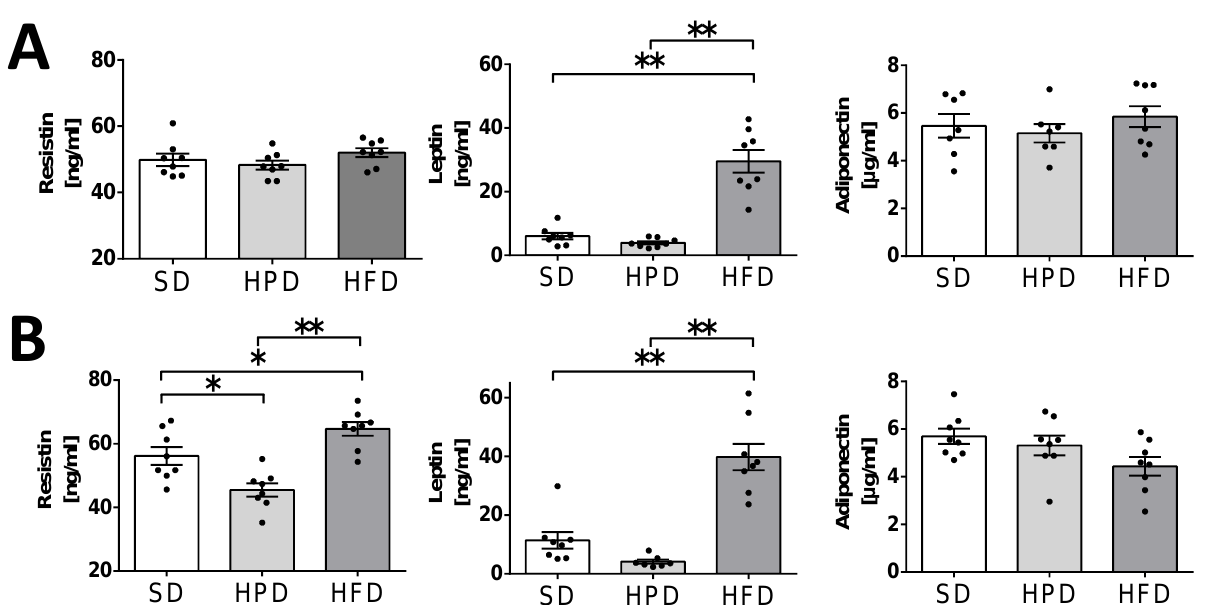
Figure 3. The effects of the standard (SD), HFD, and HPD on resistin, adiponectin, and leptin concentrations in blood serum after 60 ( A ) and 120 ( B ) days. Values presented are means and SEM for n = 8; significant differences between means for control and experimental groups are marked for p < 0.05 (*) and p < 0.01 (**).